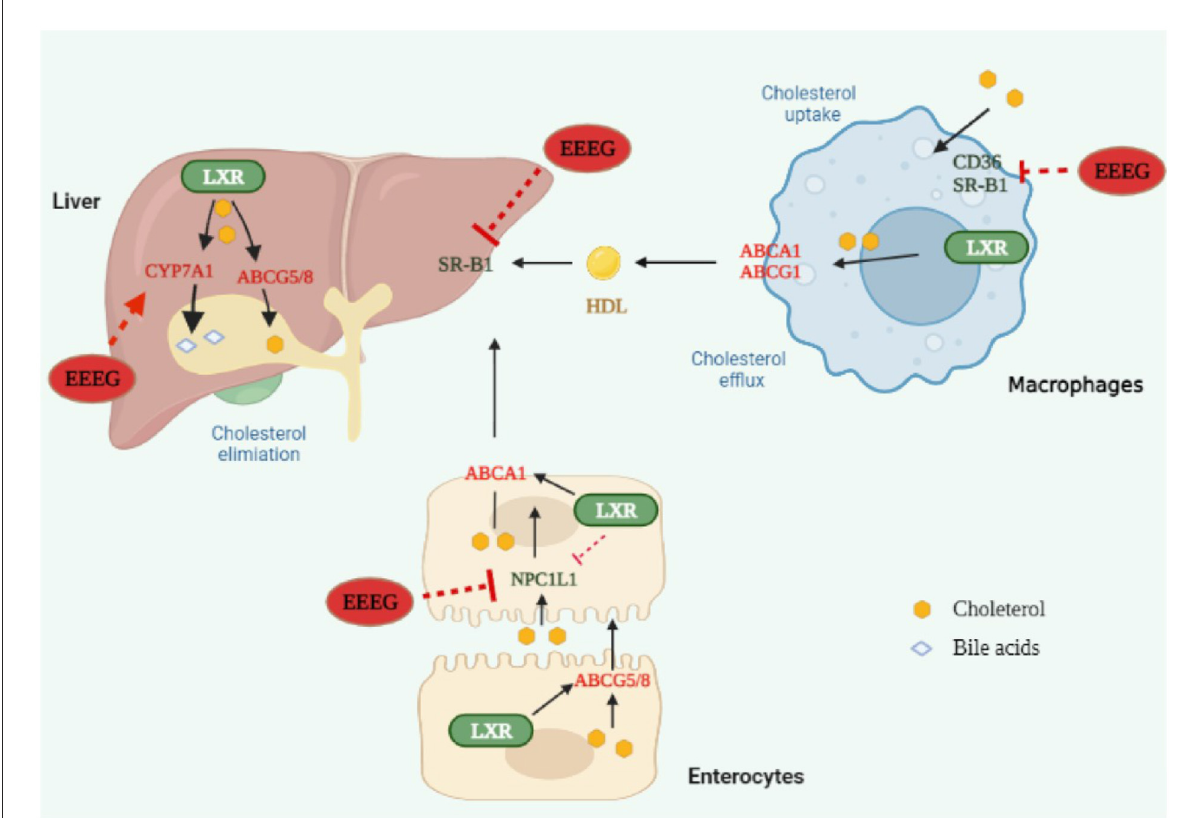
FIGURE8 Edgeworthia gardneri (Wall.) Meisn attenuates atherogenesis in mice by inhibiting macrophage foam cell formation via decreasing CD36-mediated ox-LDL uptake. EEEG inhibited macrophage-derived foam cell formation induced by oxidized low-density lipoprotein (ox-LDL) by reducing CD36-mediated lipoprotein uptake. Furthermore, EEEG treatment significantly downregulated mRNA expression of hepatic Srb1 and intestinal Npc1l1 and increased expression of hepatic Cyp7a1 , which may promote the reverse cholesterol transport and decrease the serum levels of cholesterol. In conclusion, EEEG may play a role in attenuating atherosclerotic plaque formation by reducing macrophage foam cell